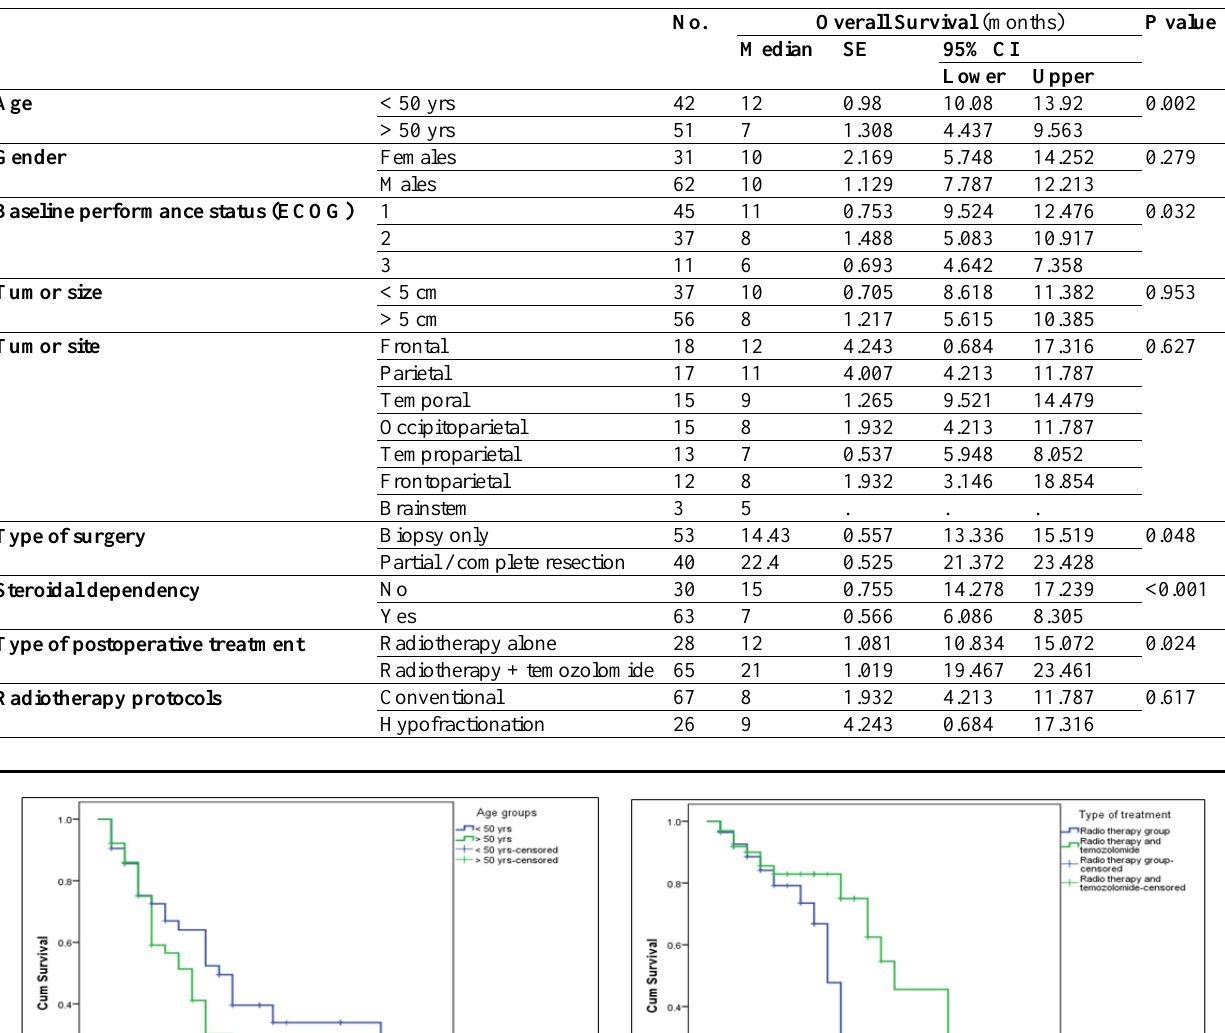
Table 3: Overall survival according to the studied variables